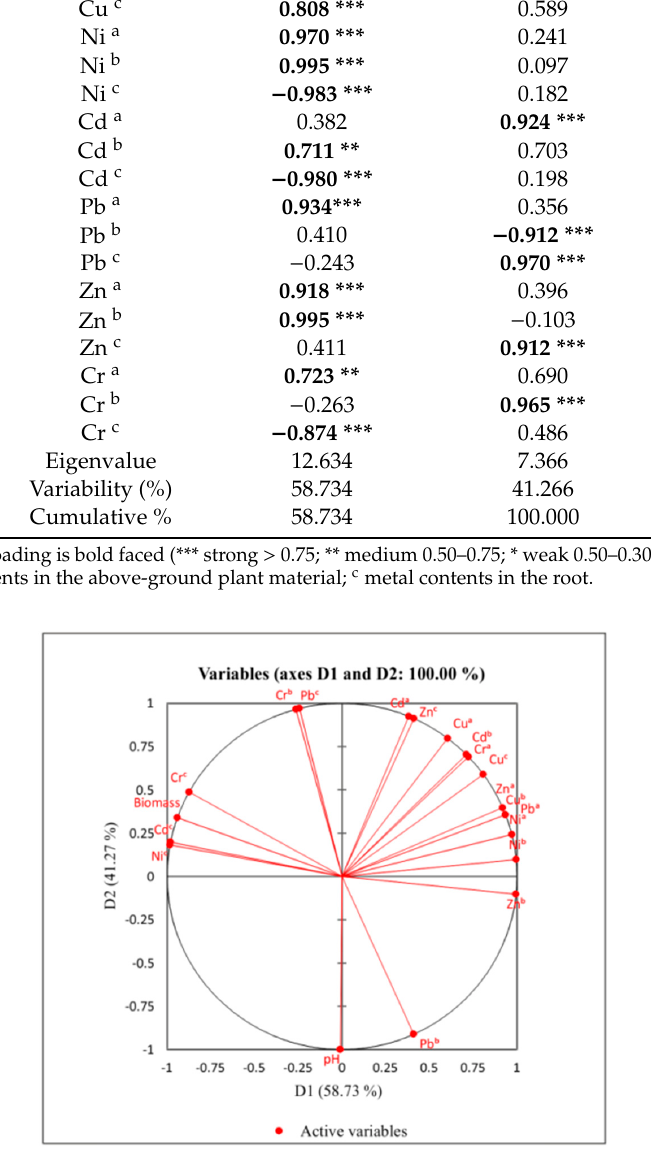
Figure 9. Plot of principal component scores (variables after varimax rotation).